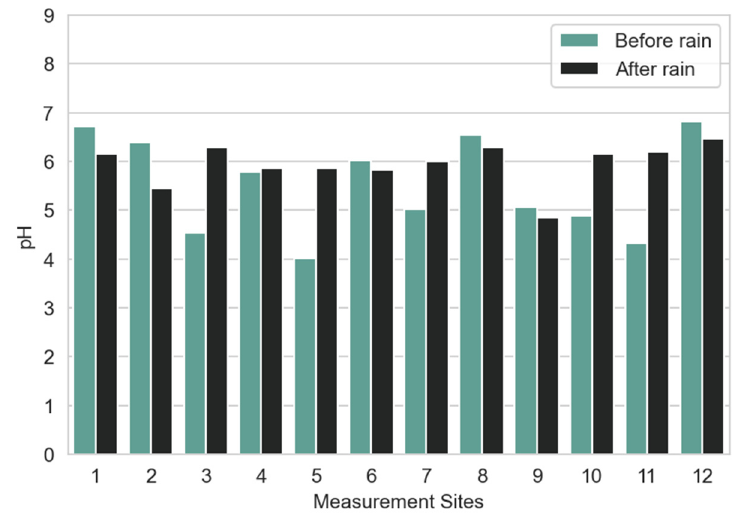
Figure 13. Average pH per measurement site before and after rain.